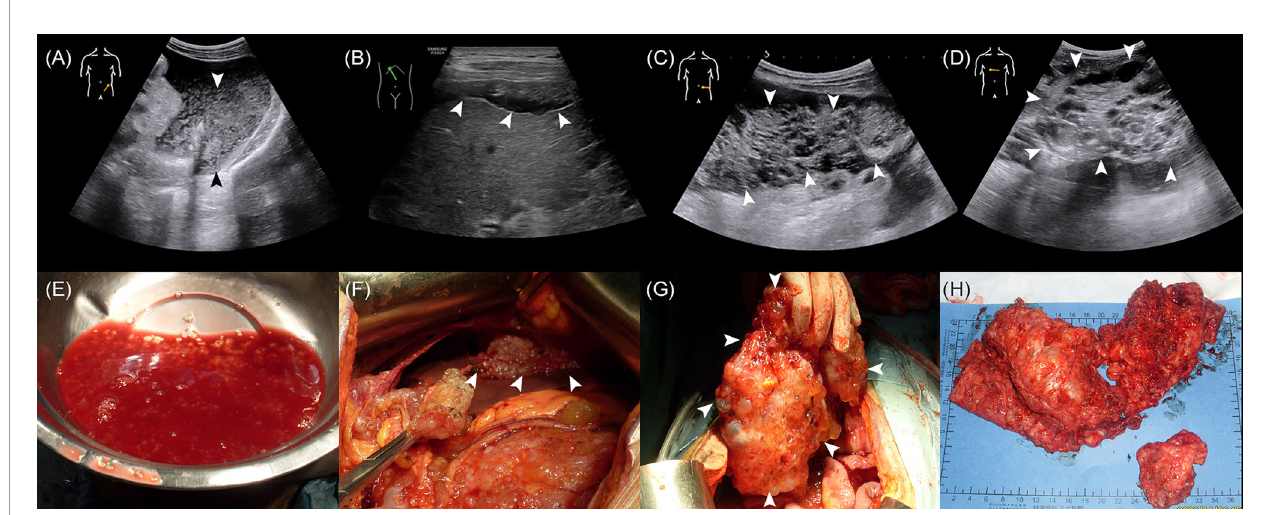
FIGURE 1 | The US characteristics and the corresponding gross specimens of PMP patients. (A, E) The absence of mucus granules ascites. (B, F) Liver scalloping. (C, G) Omental cake. (D, H) Abdominal mass.